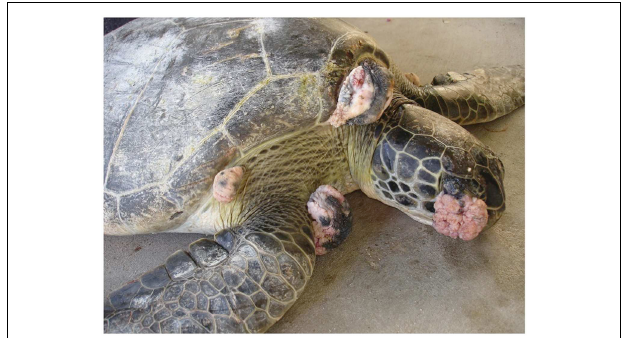
FIGURE 1 | Green turtle showing externally visible signs of fibropapillomatosis (FP). This image was shown to fishers during interviews (Photo: A.